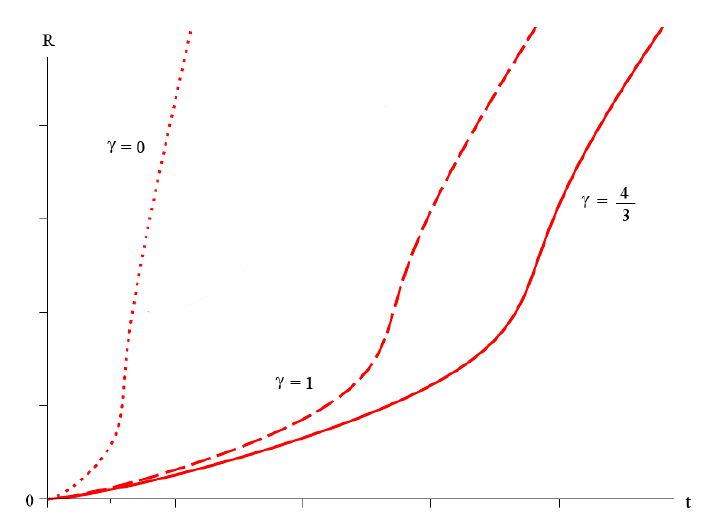
Figure 5. Areal radii of the apparent horizons for Brans-Dicke coupling ω = − 1/3. The dotted curve corresponds to γ = 0. In all three cases shown here, there are a single expanding horizon and a naked